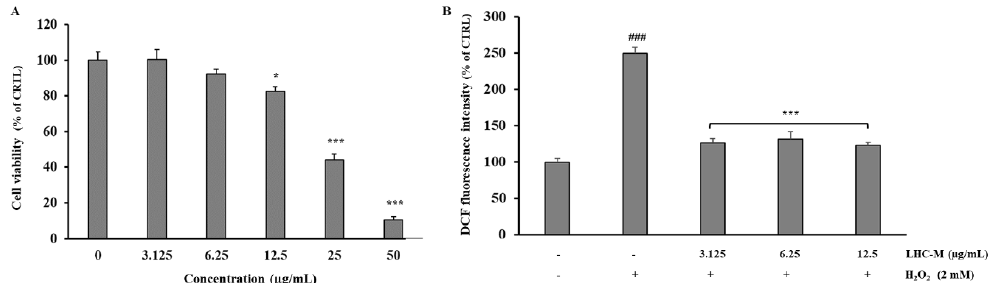
Figure 4. Effect of H. crepitans extract loaded liposomes (LHC-M) on cell viability and H 2 O 2 -induced intracellular ROS generation in HepG2 cells. ( A ) Viability of HepG2 cells treated for 24 h with different concentrations of LHC-M. Untreated cells were used as control (CTRL; 100% viability). Data are expressed as the mean ± SE of three independent experiments (n = 3) and were analyzed by one-way ANOVA followed by Dunnett’s post hoc test, * p < 0.05 and *** p < 0.001 vs. CTRL. ( B ) Cells were pre-treated for 24 h with LHC-M at different concentrations (3.125, 6.25 and 12.5 μg/mL) and subsequently incubated for 1 h with 2 mM H 2 O 2 . ROS generation was measured by flow cytometry using 2′,7′-dichlorodihydrofluorescein diacetate (DCFH-DA) staining. Data are expressed as the mean ± SE of three independent experiments (n = 3) and were analyzed by one-way ANOVA followed by Dunnett’s post hoc test. ### p < 0.001 vs. CTRL (HepG2 cells treated with vehicle), *** p < 0.001 vs. H 2 O 2 -treated cells.